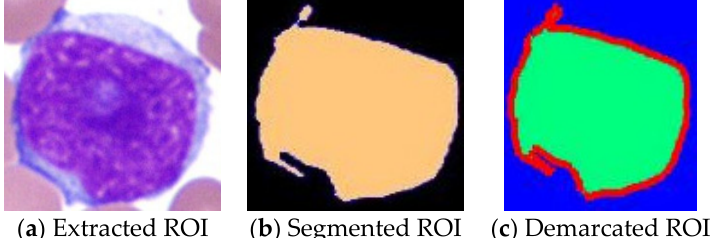
Figure 12. Image ( a ) is extracted region of interest by manual segmentation data set, image ( b ) is the outcome after proposed k-means clustering approaches, and image ( c ) is the outcome of the proposed algorithm.